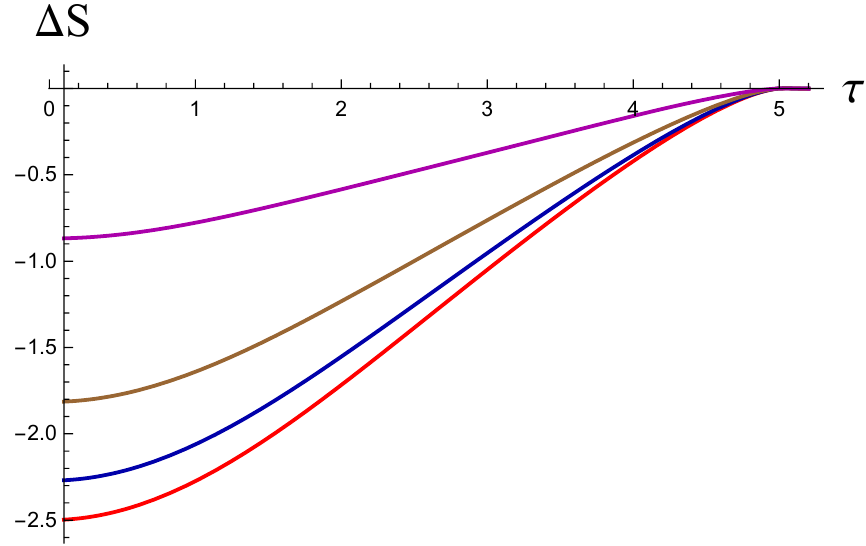
Figure 3 . The dependence of (cid:1) S on time (cid:28) for ‘ = 5 for di(cid:11)erent values of z H = 1 ; 3 ; 2 ; 1 : 3 from down to